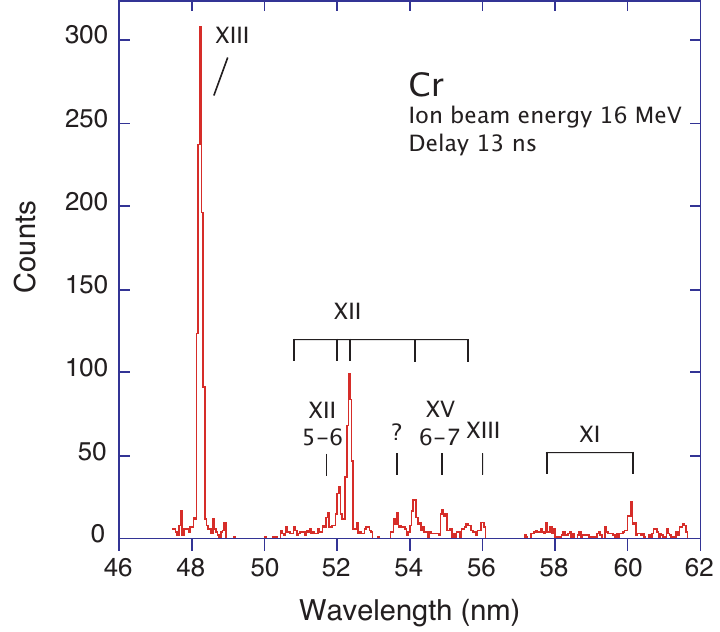
Figure 17. Beam-foil spectrum of Cr at an ion beam energy of 16 MeV. Observation 100mm down- stream of the foil. Line width (FWHM) 0.15nm. The strongest lines are identified by the spectrum number. Lines of three intercombination transition arrays are seen (Mg-like CrXIII, Al-like CrXII and Si-like CrXI). Several spectral features can be identified with yrast transition